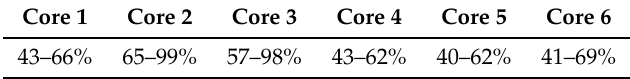
Table 5. The CPU usage in NVIDIA Jetson TX2.